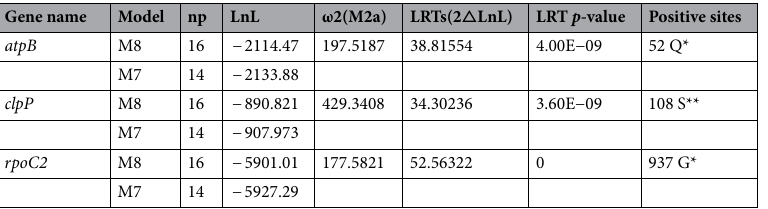
Table 4. The summary of positive selective pressure analysis on genes in M2a, M7 vs. M8 model. *Means p < 0.05, **means p <